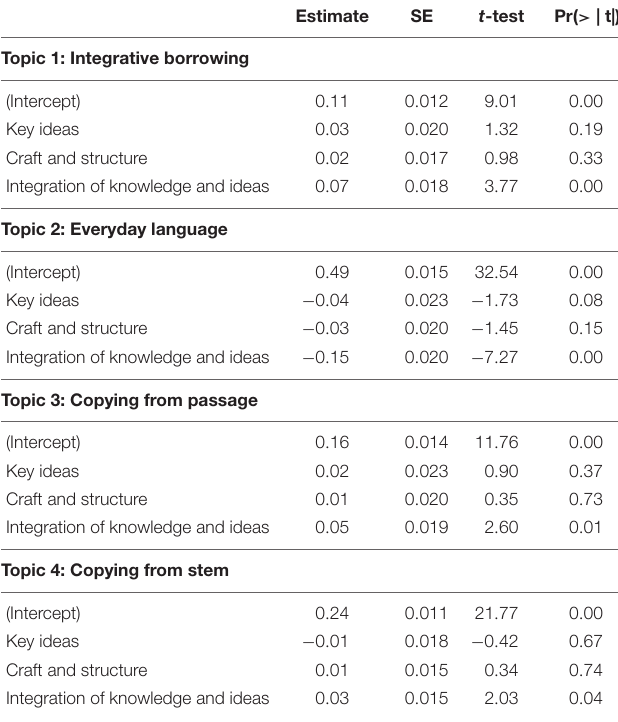
TABLE 5 | Results of STM for predicting the use of topics by mastery status of reading